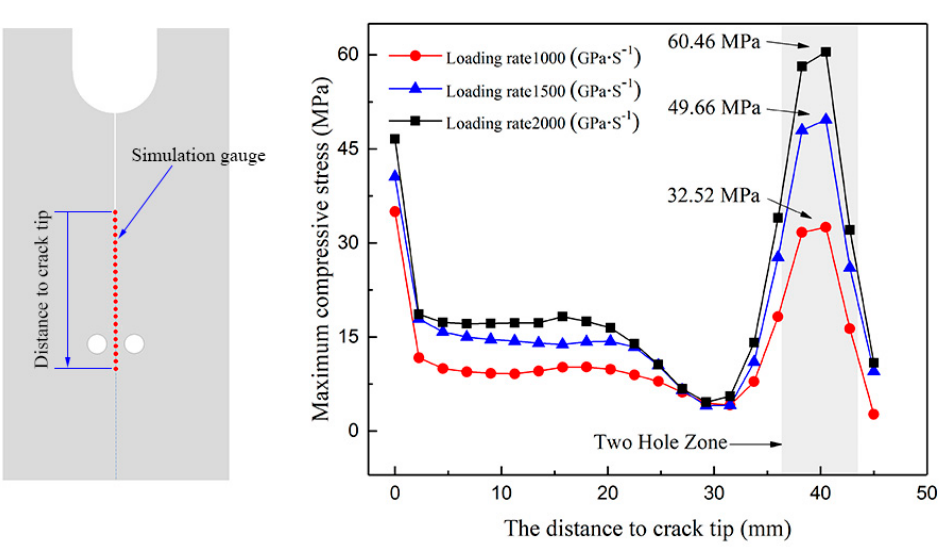
Figure 12. Location map of gauges and maximum compressive stress curves of gauge points.